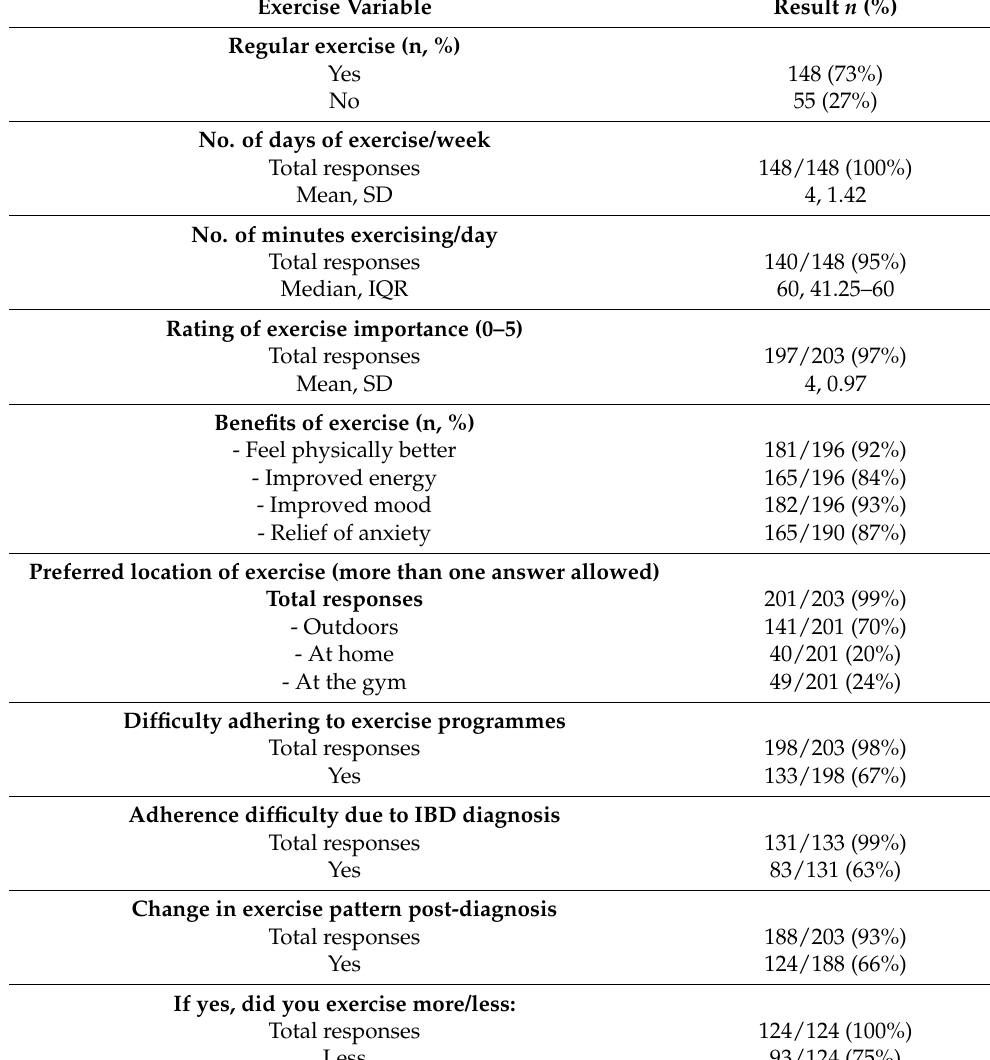
Table 3. Results of Exercise